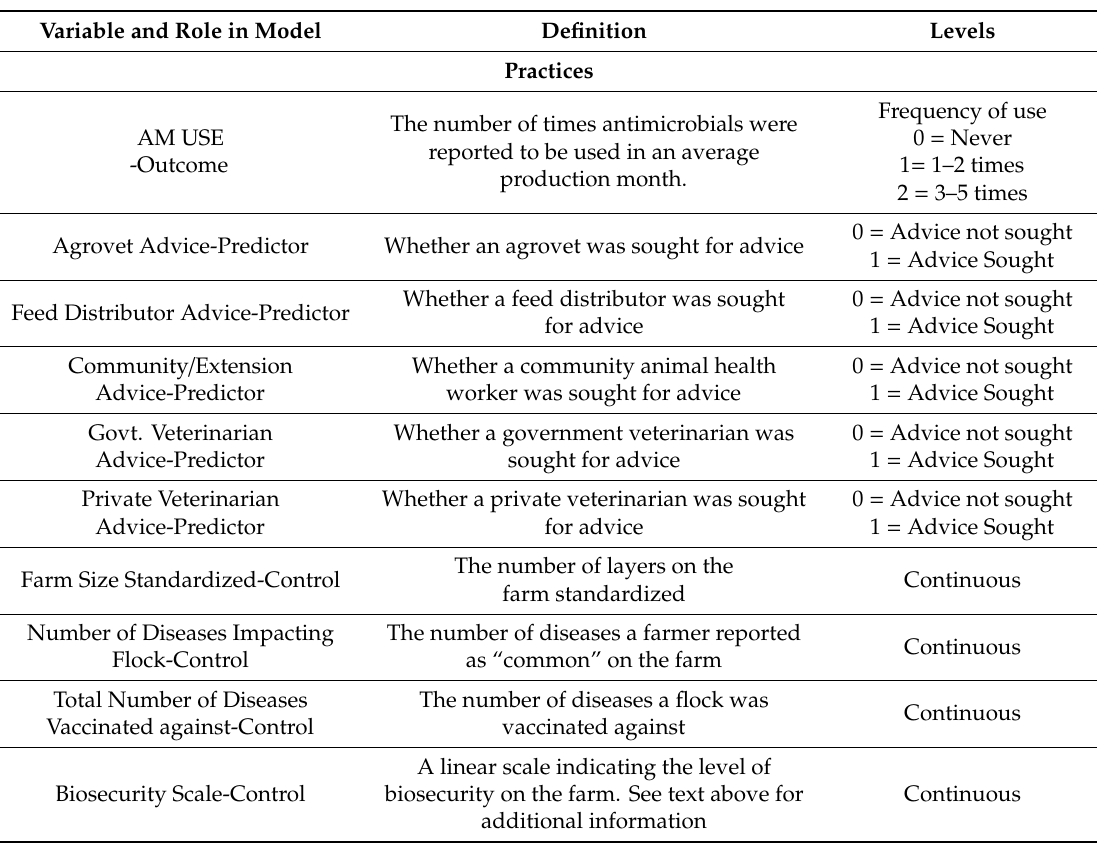
Table 1. Variables included in the multivariate ordinal logistic model. The variable column corresponds to the variable name in models. The level column indicates the coding of the variable (e.g., 0 = never for AM USE variable). For variables with levels of “continuous” please see Table 3 for ranges. All data are self-reported by survey